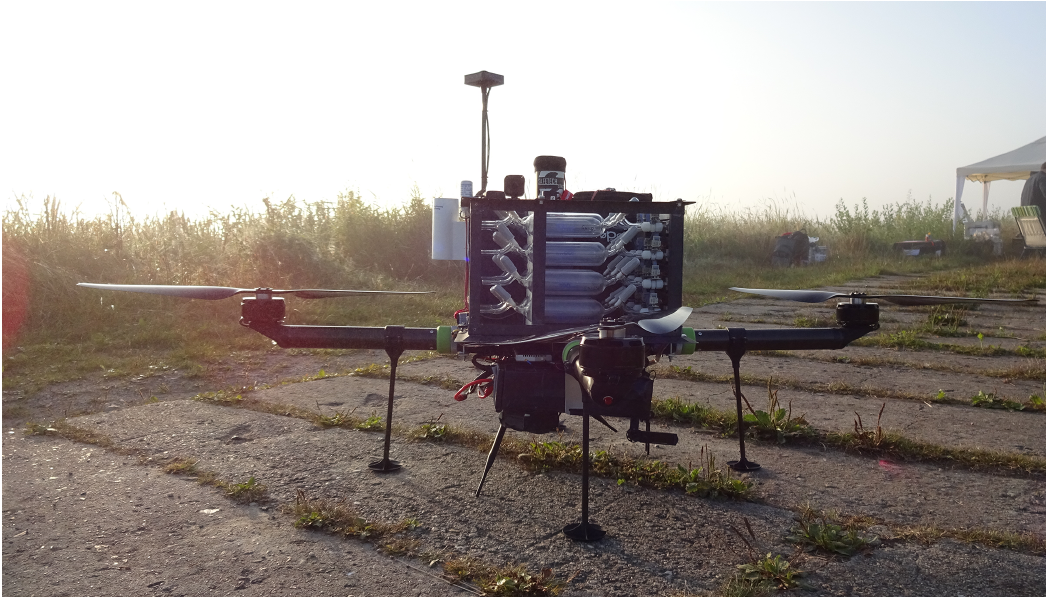
Figure 1. The quadrocopter ALICE before take-off in Zarnekow on 5 September 2018.